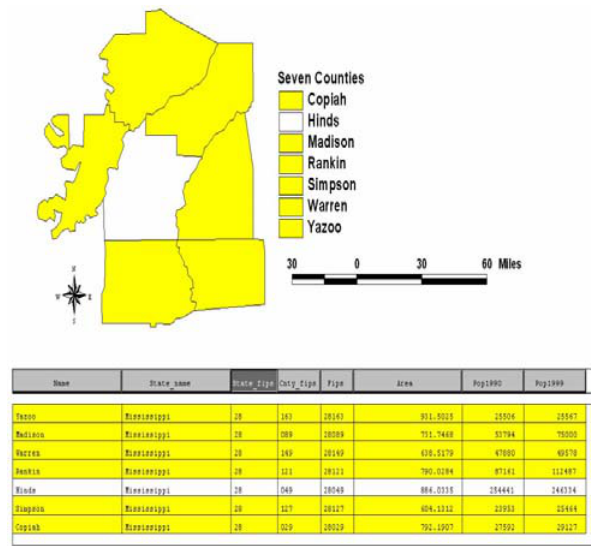
Figure 3.2: Population Change by County 1990-2000